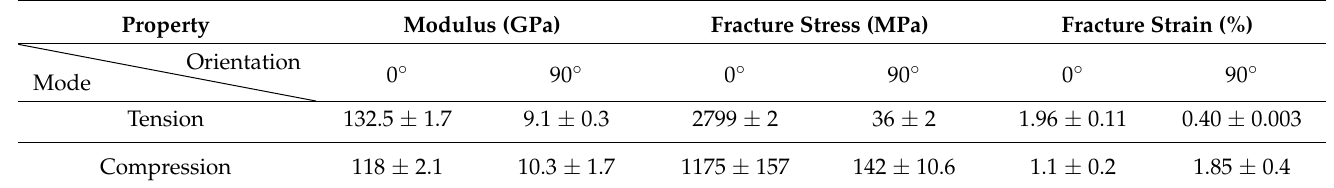
Table 8. Comparison of mechanical properties between tension and compression of uniform cou- pons.